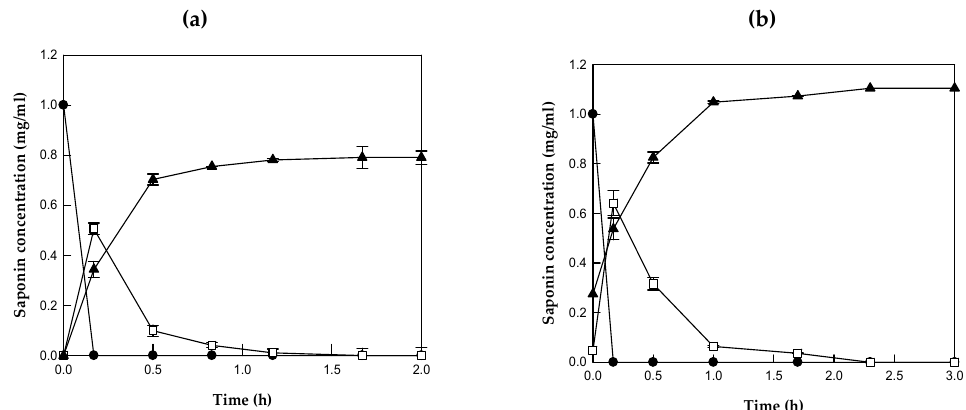
Figure 4. Biotransformation of ( a ) reagent-grade platycoside E (PE) into platycodin D (PD), and of ( b ) 1 mg / mL PE and 0.04 mg / mL platycodin D3 (PD3) in Platycodi radix extract into PD, by Caldicellulosiruptor bescii β -glucosidase under optimum reaction conditions at 80 ◦ C. Closed circle, PE; open square, PD3; and closed triangle, PD. The PD production mixture contained 50 mM citrate / phosphate bu ff er (pH 5.5), 0.07 mg / mL enzyme, and 1 mg / mL reagent-grade PE; or 50 mM citrate / phosphate bu ff er (pH 5.5), 0.5 mg / mL enzyme, and Platycodi radix extract (containing 1 mg / mL PE, 0.04 mg / mL PD3, and 0.27 mg / mL PD). Data are the means of three experiments, and error bars represent the standard deviation.